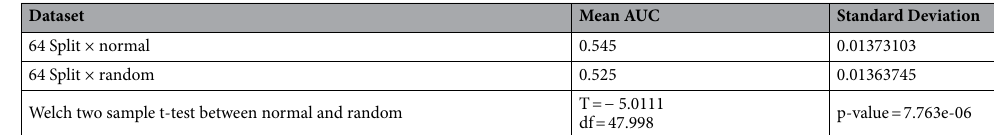
Dataset Mean AUC Standard Deviation 64 Split × normal 0.545 0.01373103 64 Split × random 0.525 0.01363745 Welch two sample t-test between normal and random T = − 5.0111 df = 47.998 p-value = Table 4. This table shows a comparison of the age and sex matched models using 64 Split chromosome X data. The reported mean AUCs demonstrates that a portion of the previous performance is attributed to differences between male and females in X Chromosome CSLV levels as shown in Supplementary Information D. However, it still performs better than randomly guessing.